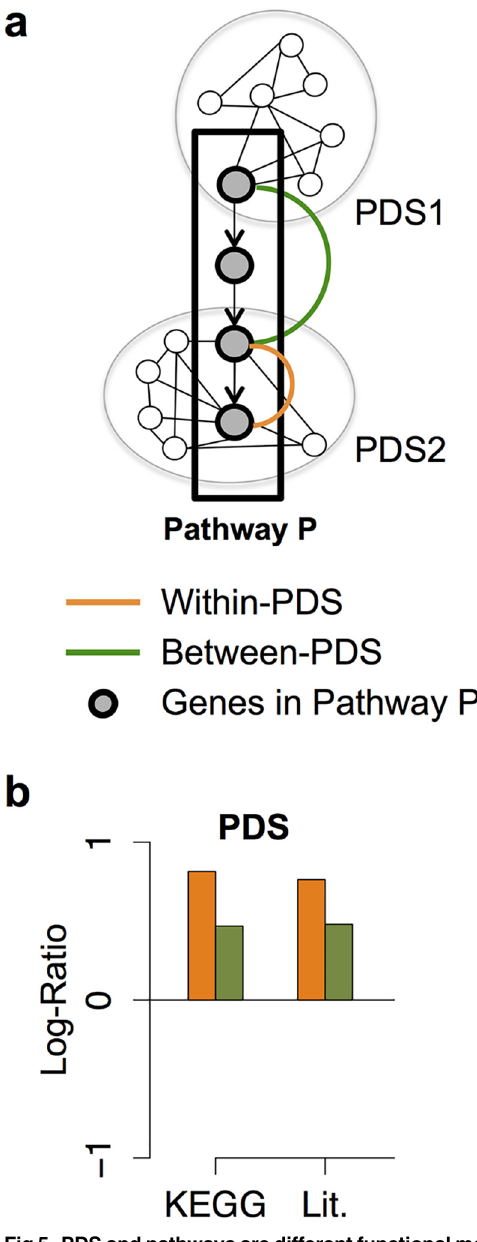
Fig 5. PDS and pathways are different functional modules. (a) Schematic representation of possible relationships between Pathways and protein-protein interaction dense subnetwork (PDS). Each node represents a gene product connected by a PPI (black lines) or by a functional relationship within a pathway P (back arrows). The grey nodes represent gene products involved in a pathway P. An orange line linking two grey nodes indicates that these two genes/proteins interact within-pathway and also within-PDS. A green line linking two grey nodes indicates that these two genes/proteins interact within-pathway and between-PDS. (b) Log-Ratio scores for within-PDS and between-PDS relationships occurring within-pathways. A positive Log- Ratio score means that the frequency of within-pathway relationships occurring also within-PDS (orange bars) or within-pathway relationships occurring between-PDS (green bars) is higher than the frequency of similar situations witnessed in relevant randomized pathway networks.